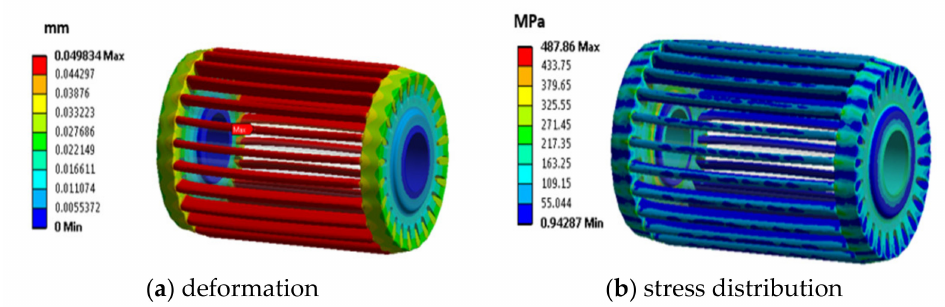
Figure 13. Rotor squirrel-cage: ( a ) application of lamination deformations as a boundary condition, ( b ) resultant stress distribution in the